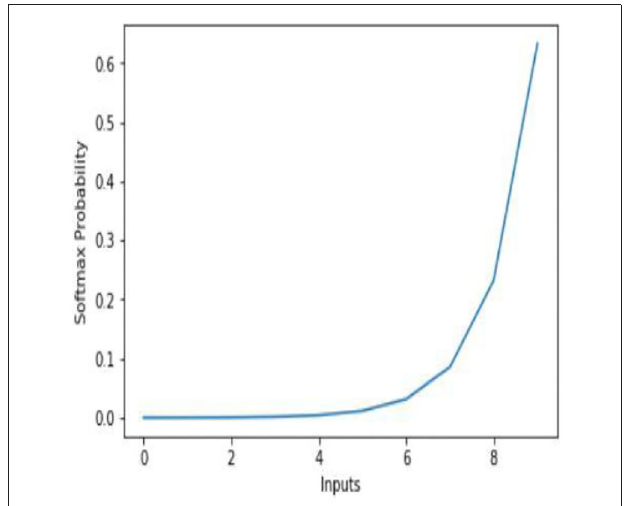
FIGURE 6 | Softmax activation function.